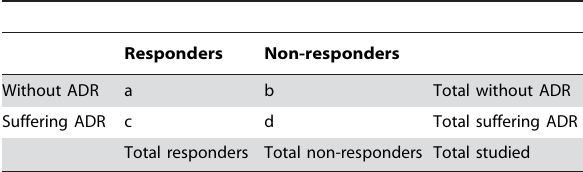
Table 2. Table combining efficacy and safety results of a theoretical CRT when two drugs have been studied.